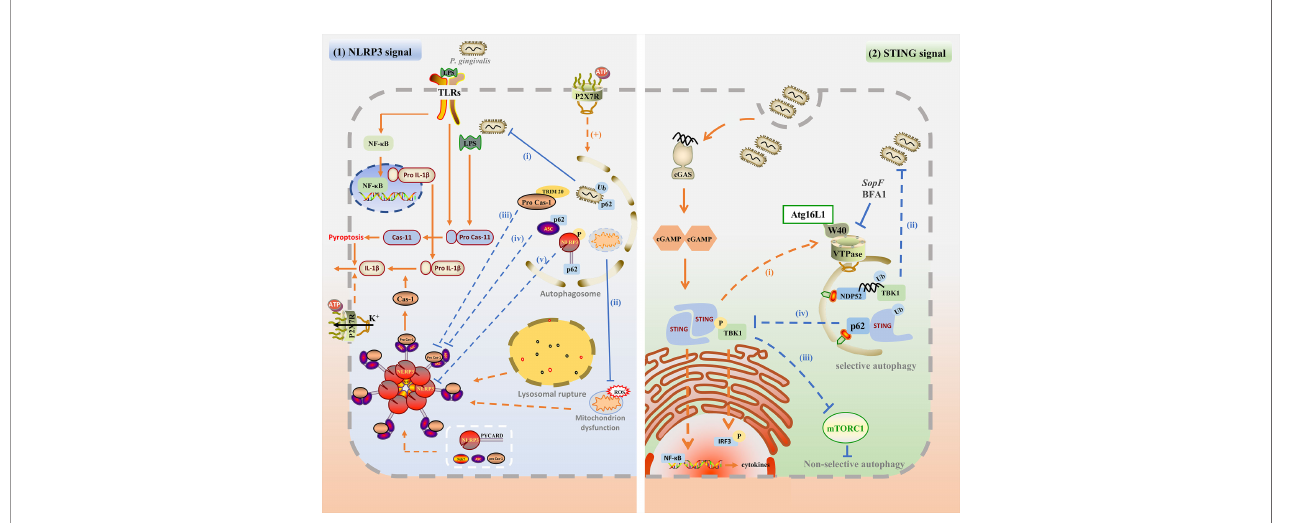
FIGURE 2 | The possible mechanisms involved in the interaction between autophagy and P. gingivalis -induced in fl ammation. (1) Upon P. gingivalis infection, NLRP3 in fl ammasome can be activated by TLR/NF- k B signal, ROS generation, P2X7R and potassium ef fl ux, and lysosomal rupture. The assembly of NLRP3 in fl ammasome promotes caspase-1 maturation as well as active IL-1 b secretion, and pyroptosis. Autophagy may inhibit NLPR3 in fl ammasome by degrading intracellular P. gingivalis (i), dysfunctional mitochondrion (ii), phosphorylated NLRP3-PYCARD (iii), ubiquitinated ASC (iv), and pro-caspase-1 (v). Besides, P2RX7 activation may promote the autophagy fl ux, which is bene fi cial for bacterial degradation. (2) Autophagy may regulate the cGAS-cGAMP-STING pathway. cGAS may detect P. gingivalis infection by its dsDNA, and activate downstream cGAMP and STING. STING recruits and phosphorylates TBK and activated TBK1 kinase phosphorylates downstream IRF3. STING also activates NF- k B to induce IFN and other cytokines. Activated STING may recruit Atg16L1 and interact with VTPase via its WD40 domain to promote autophagy for degradation of P. gingivalis (i). Cytosolic dsDNA may be directly targeted for autophagosome via ubiquitin, TBK1, and NDP52- mediated xenophagy for degradation (ii). Besides, STING and TBK1 kinase may promote non-selective autophagy by inhibiting mTORC1 (iii). TBK1 kinase may also recruit and phosphorylates p62, enhancing the af fi nity of p62 with ubiquitinated STING and promoting selective